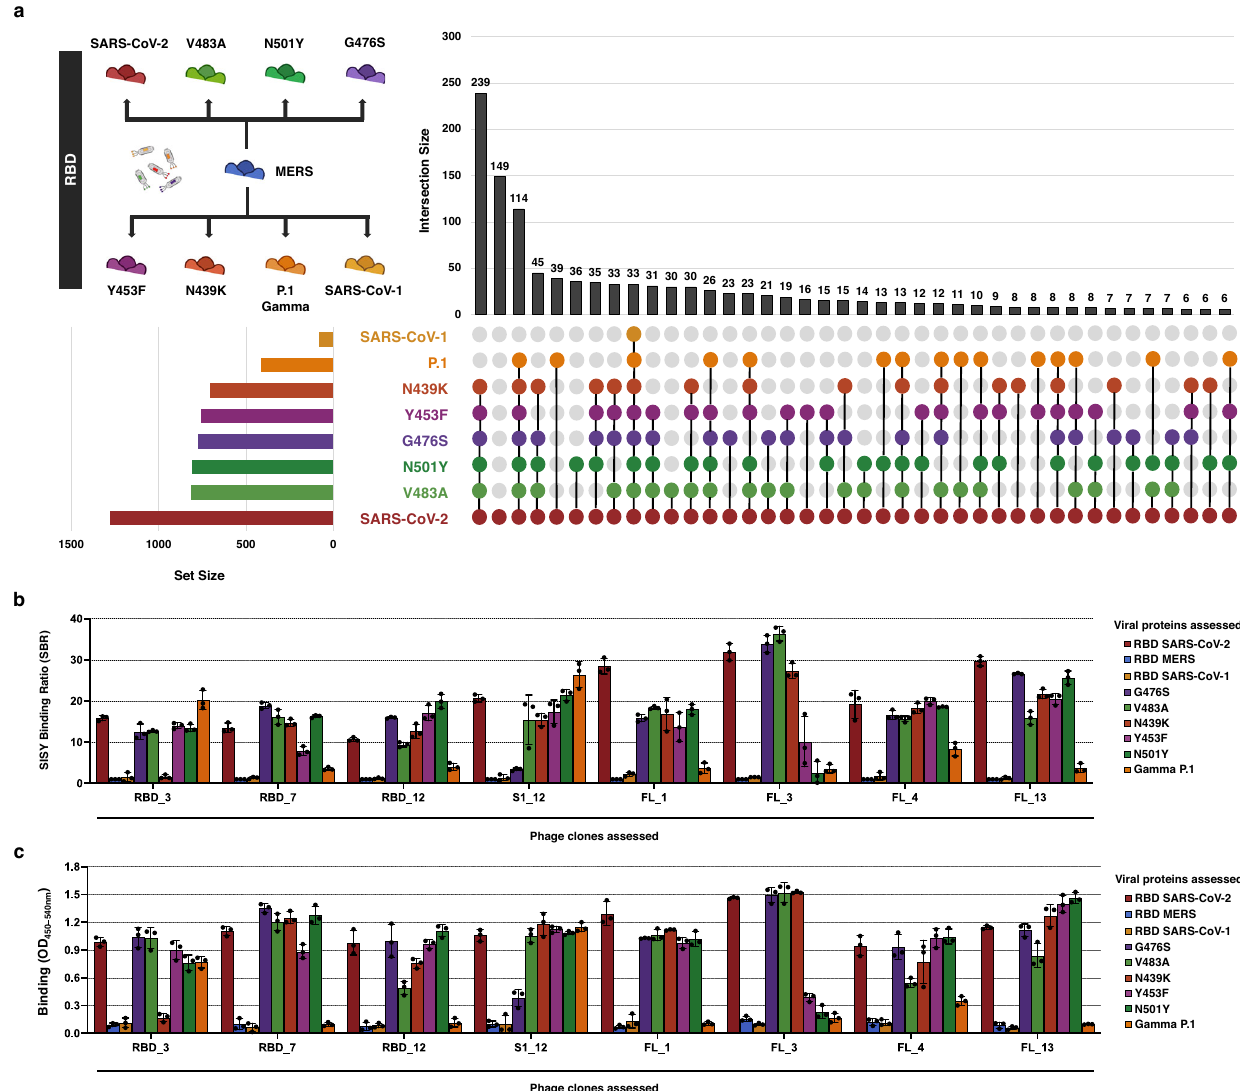
Fig. 5 | Assessment of binding across multiple variants simultaneously using SLISY.a AssessingclonesacrossmultipleRBDvariants.UpSetplotincludesupright bars that represent the total number of cross-reactive clones in each intersection. Filled circles below bars represent the variants that represent the intersecting set. Intersectingsetsthathavefewerthan6cross-reactivecloneswerenotrepresented.